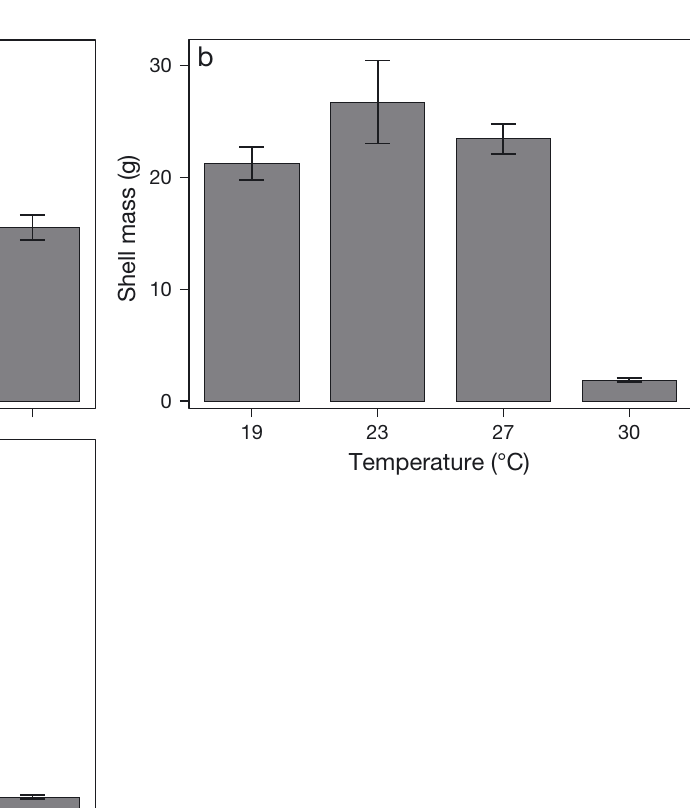
Fig. 1. Long-term effect of temperature on (a) shell length, (b) shell mass, and (c) body mass of juvenile Rapana venosa . All data are means ± SD, n = 4 for each